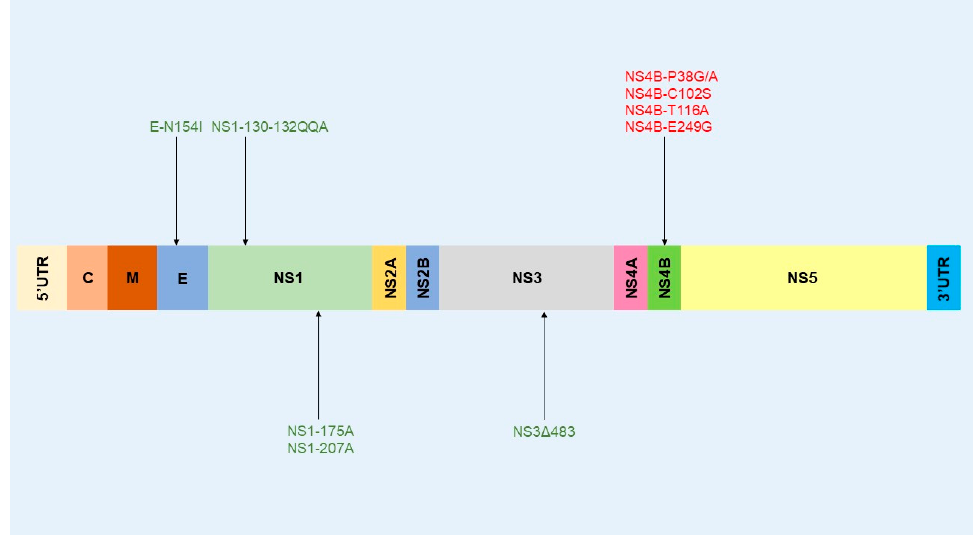
Figure 8. Virulence determinants in the WNV genome found in mosquito vectors. Molecular virulence determinants validated in vitro in the C6/36 mosquito cell line or in vivo in Culex pipiens and Culex tarsalis . Green: mutations involved in attenuated viral phenotype. Red: mutations involved in more virulent viral phenotype.